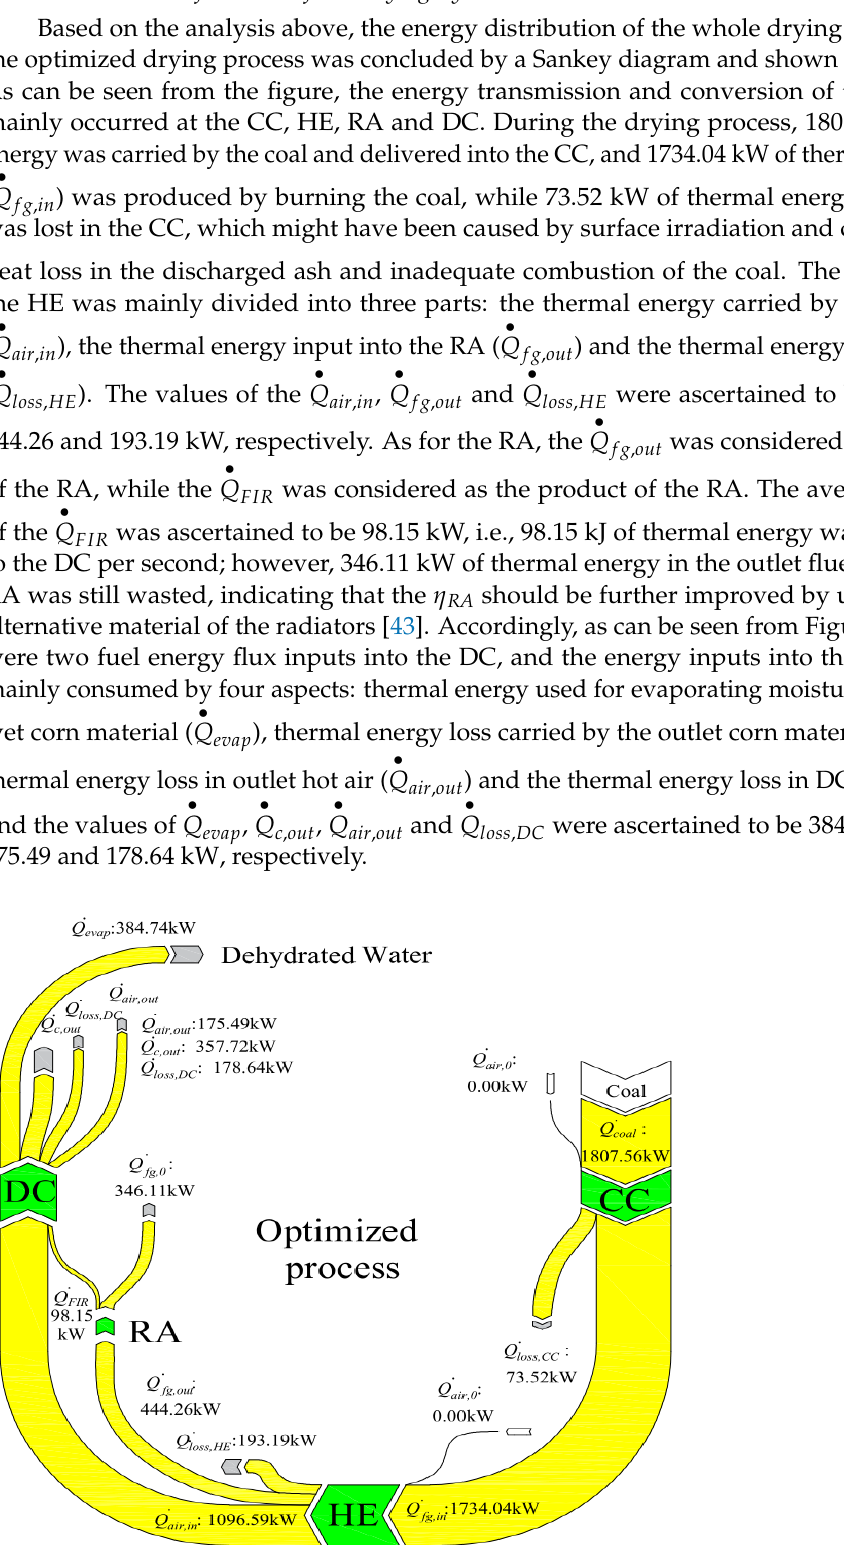
Figure 9. The Sankey diagram for the thermal analysis of the overall drying system.